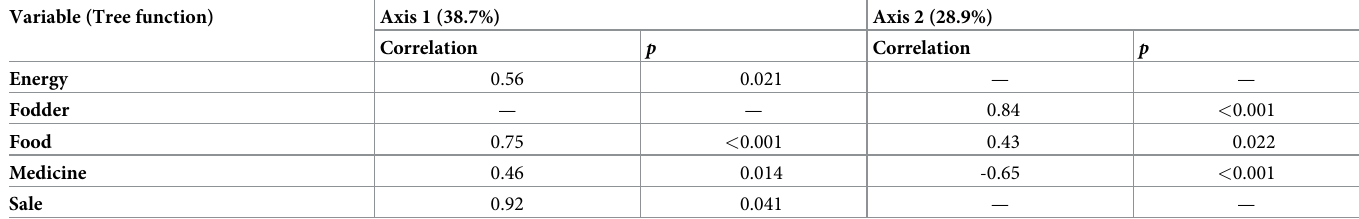
Table 3. Description of the PCA dimensions by their correlation coefficients with the tree functions listed by the discussion group participants in the four villages (Cassou, Dao, Kou and Vrassan) in Ziro province of Burkina Faso. Variable (Tree function)